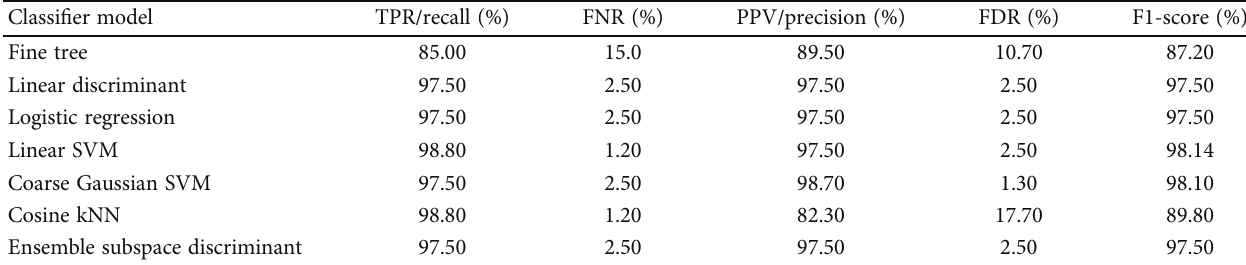
Table 5: The classi fi cation performance for pneumonia with SURF features.